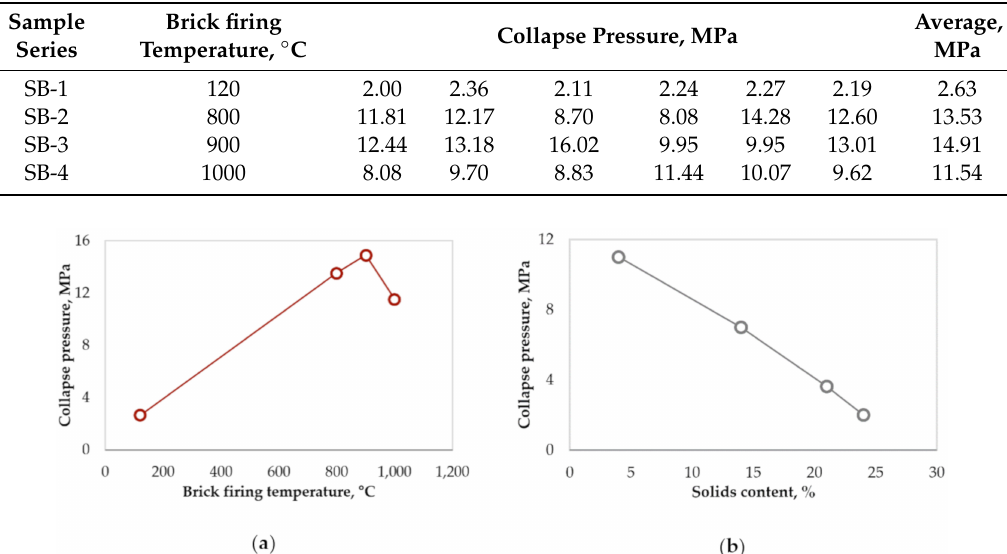
Figure 3. Experimental curves of the brick strength properties as a function of ( a ) baking temperature; ( b ) total weathered solids, viz. saponite, quartz, montmorillonite, dolomite, calcite, hematite, K-feldspar, and almost certainly a talc-pyrophyllite mineral